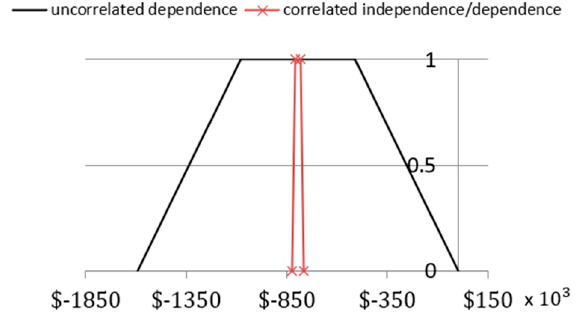
Figure 5. Uncorrelated dependence costs recognised with the difference of B and C.